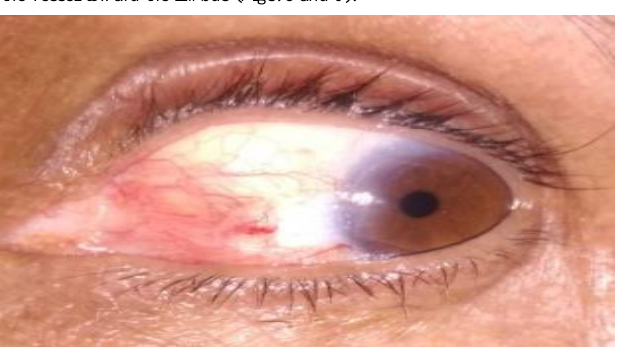
Fig. 5. Fully gained scleral and corneal thickness (Day 16 after